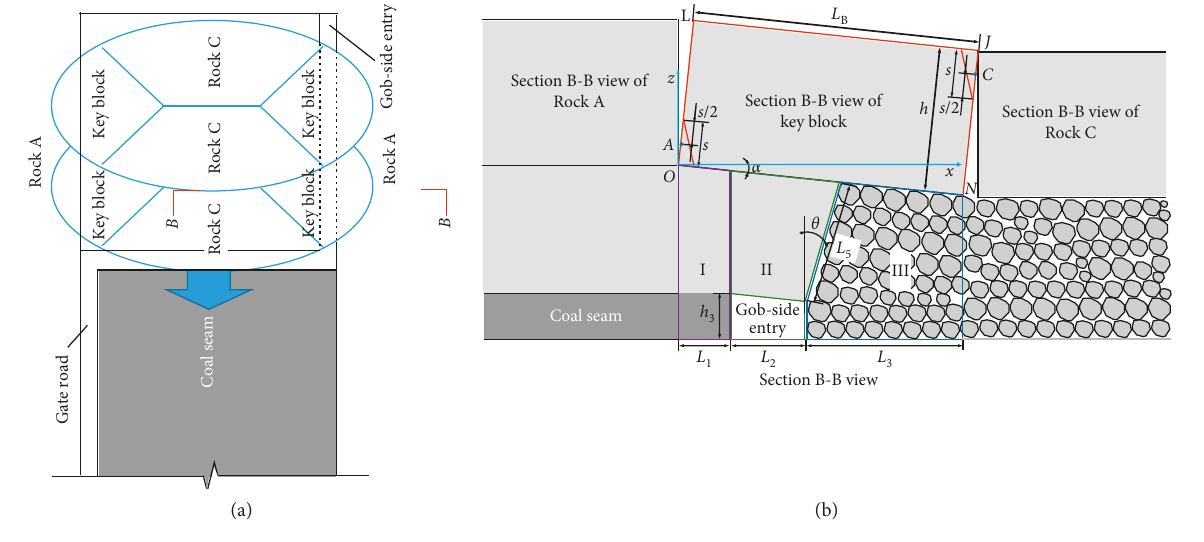
Figure 5: Structural diagram of the key block and bearing zones.